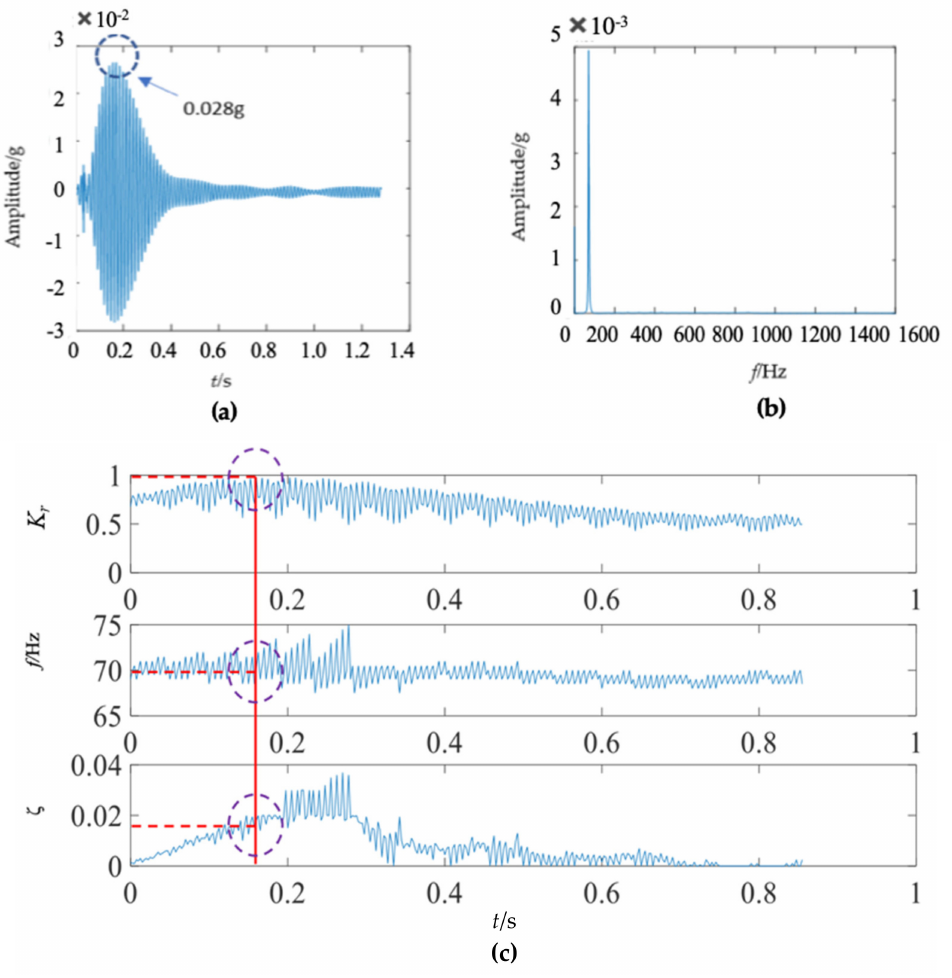
Figure 9. Third mode in the vibration response signal of the wooden utility pole labeled as 57704: ( a ) the vibration response of the third mode in the time domain, ( b ) the frequency spectrum of the third mode, and ( c ) the results of Laplace wavelet correlation filtering of the third